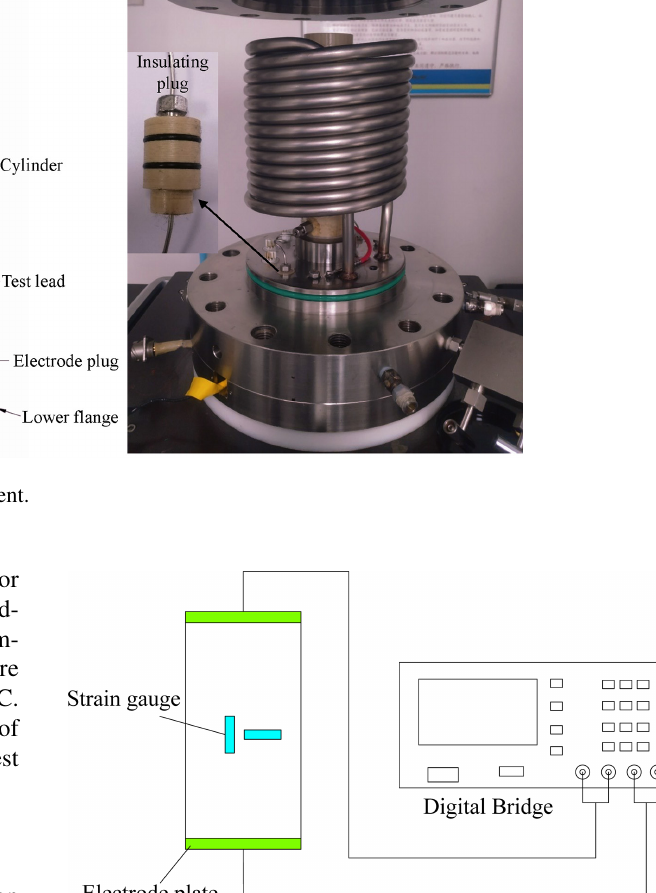
Figure 3. Schematic diagram of the resistivity test